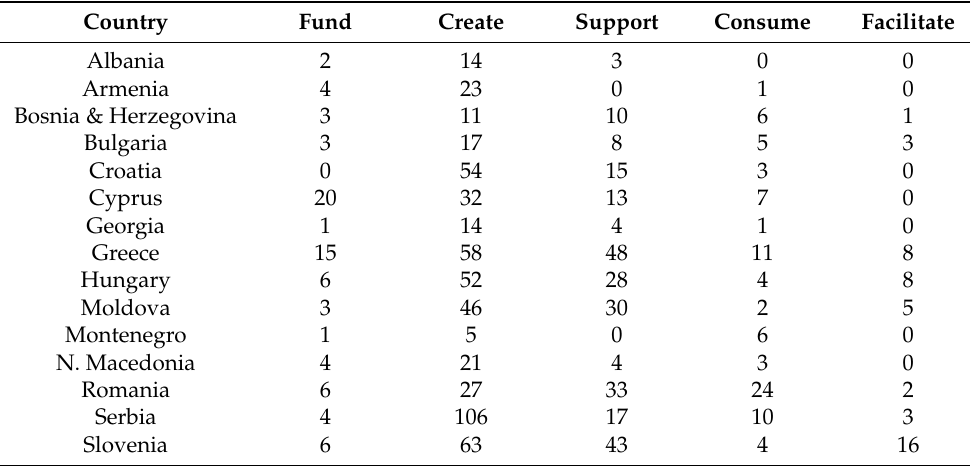
Table 3. Open Science stakeholders in the NI4OS-Europe partner countries.